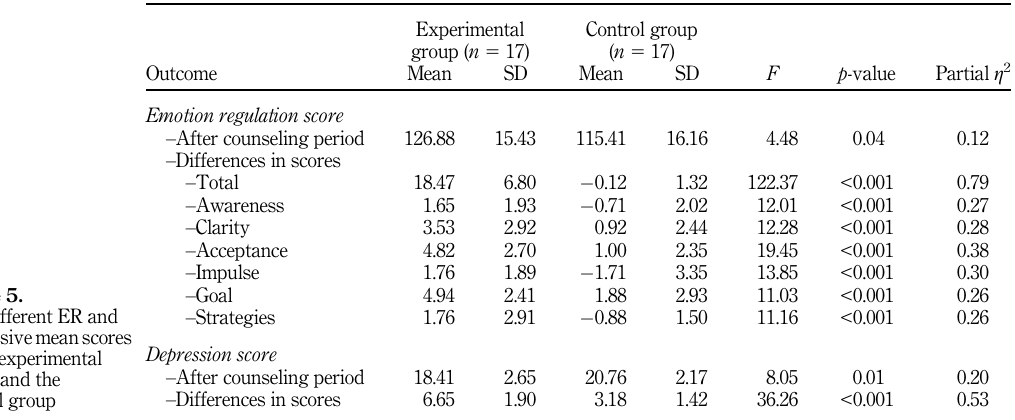
Table 5. The different ER and depressivemeanscores in the experimental group and the control